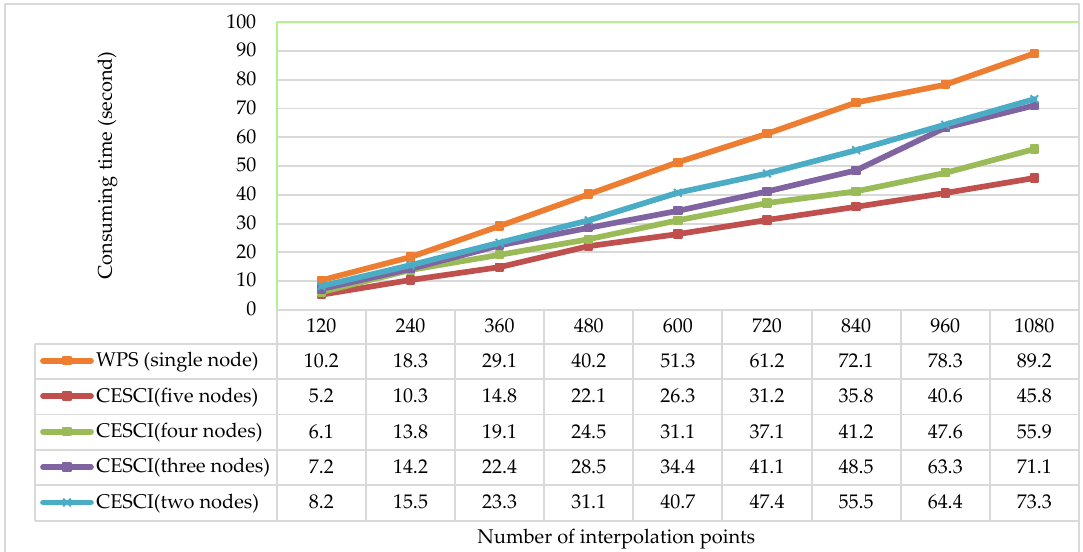
Figure 10. The Web portal, showing an on-the-fly SM map based on the proposed cyber-physical infrastructure.